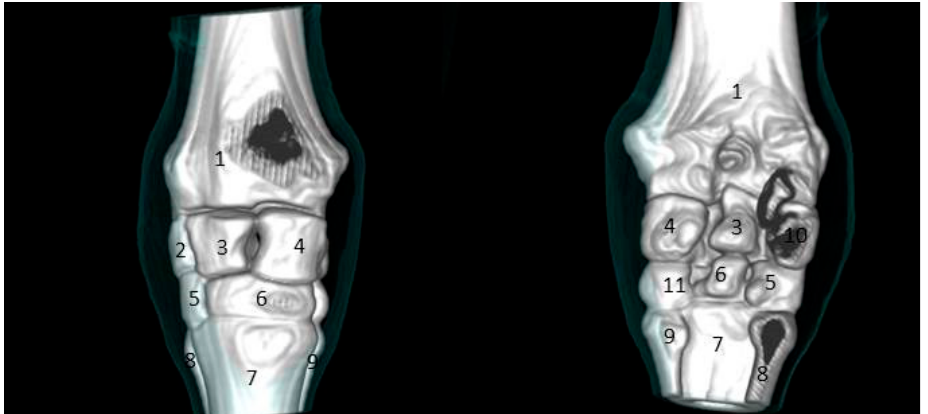
Figure 5. Three-dimensional computed tomographic scan of the carpal joint in donkeys. (1) Distal radius extremity. (2) Ulnar carpal bone. (3) Intermediate carpal bone. (4) Radiocarpal bone. (5) Fourth carpal bone. (6) Third carpal bone. (7) Third metacarpal bone. (8) Fourth metacarpal bone. (9) Second metacarpal bone. (10) Accessory carpal bone. (11) Second carpal bone.